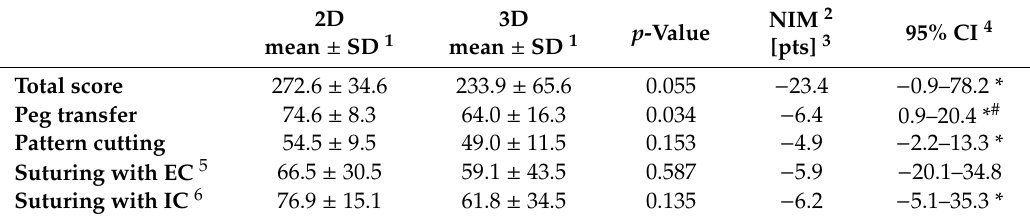
Table 3. Comparison of the score improvements for the total scores and the four di ff erent Fundamentals of Laparoscopic Surgery tasks (peg transfer, pattern cutting, suturing with extracorporeal knot tying, and suturing with intracorporeal knot tying) between groups using the respective assigned visualization